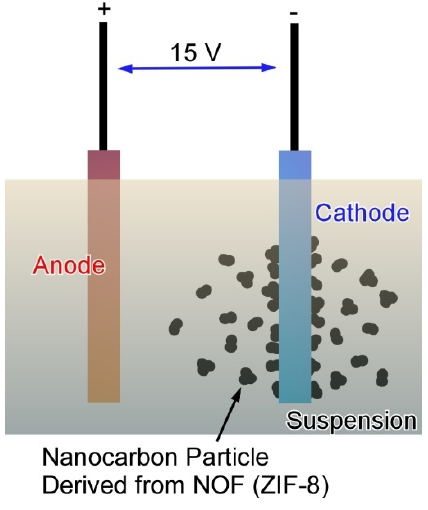
Figure 19. Fabrication of cathode electrode structures for flexible micro-supercapacitors through electrophoresis method nanocarbon materials prepared from ZIF-8 particles.